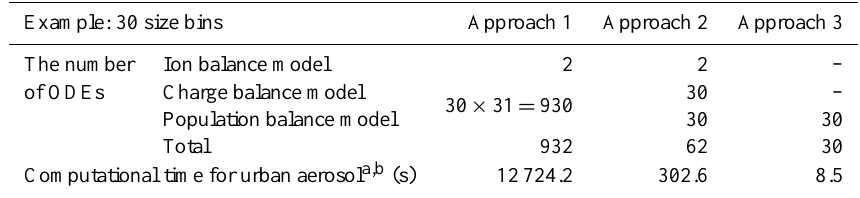
Table 3. Computational costs of the approaches used.